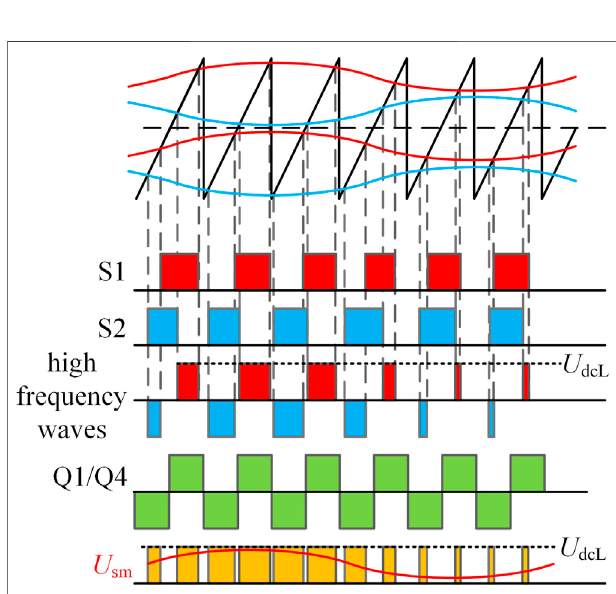
FIGURE 4 | Modulation of the ISM output voltage U sm by regulating the duty cycle of the high frequency waves with AC and DC modulation